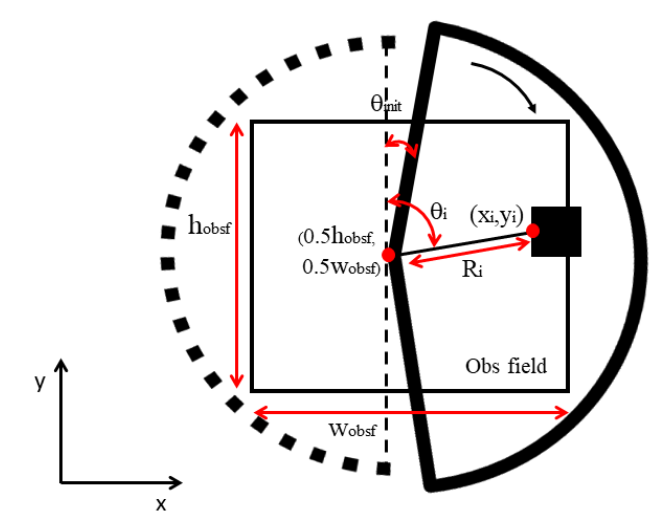
Figure 3. Mapping the obstacle point in the obstacle field. The explanation of the notation in the Figure can be found in Equation